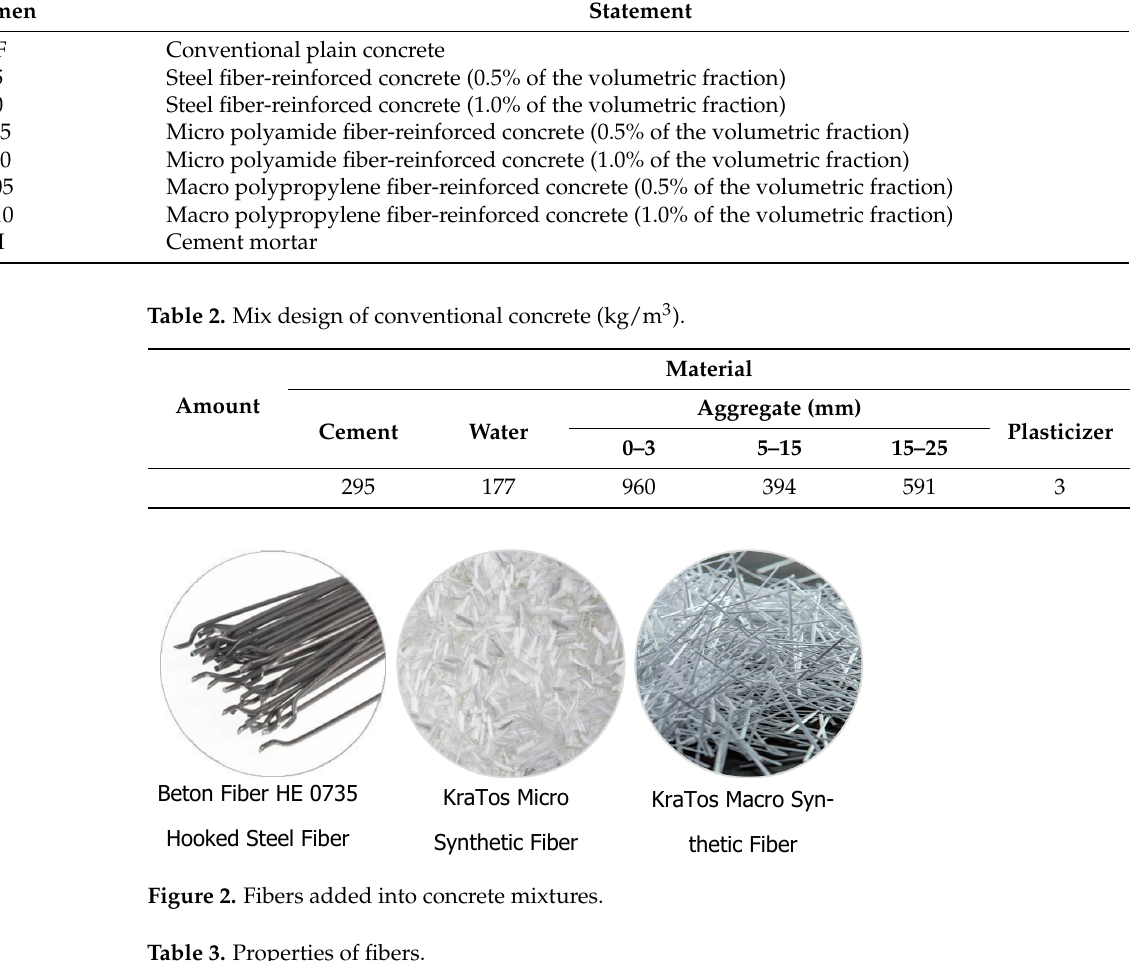
Table 1. Descriptions of the test specimens.